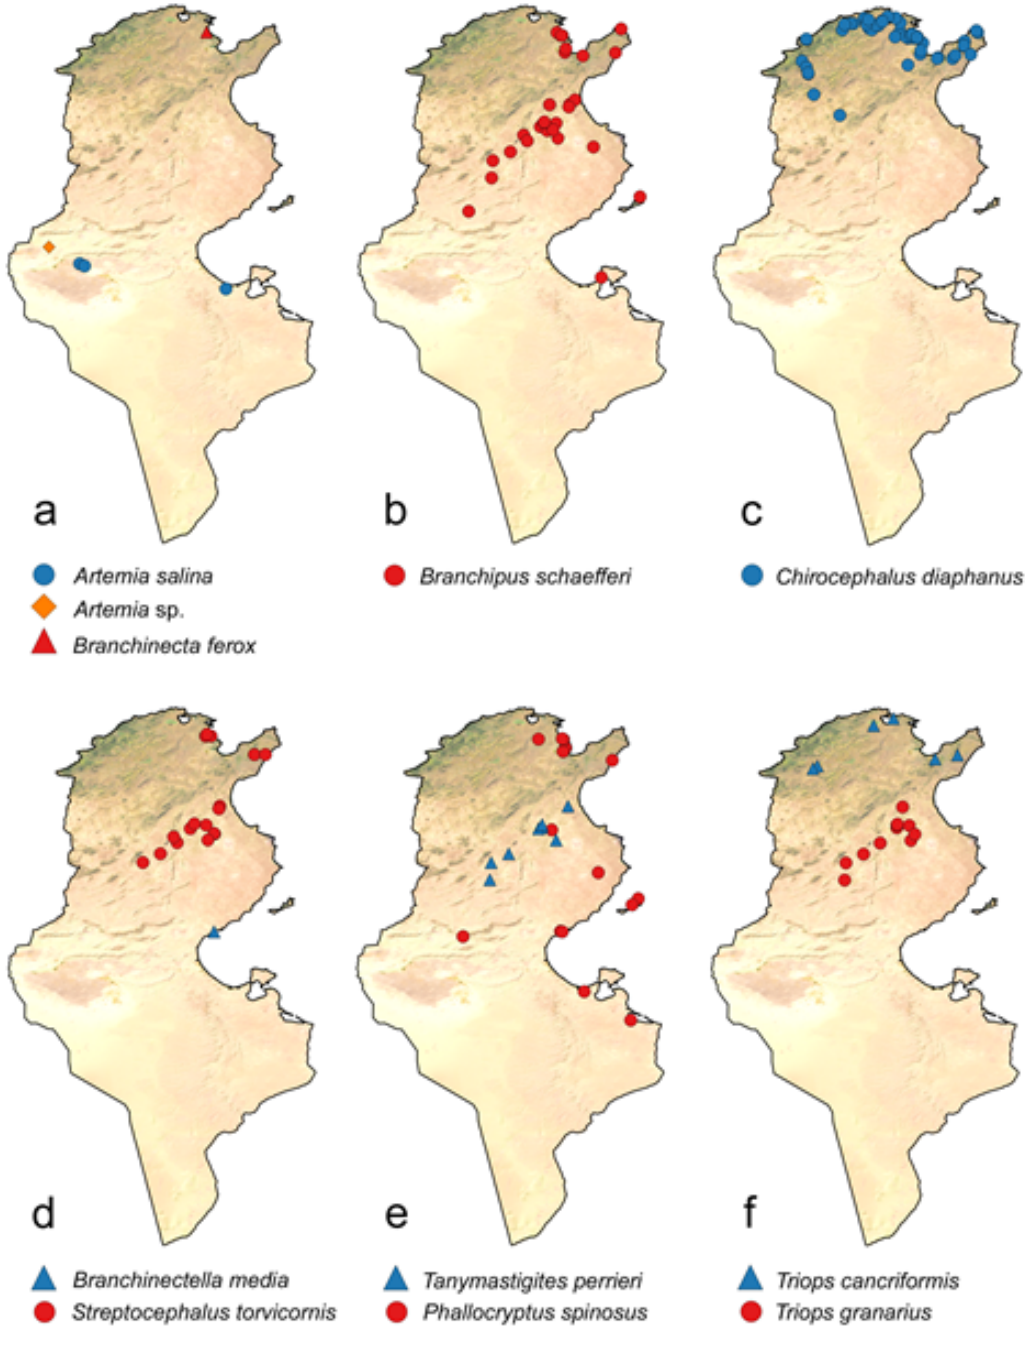
FIGURE 2. Distribution maps of selected Tunisian large branchiopod species based on present